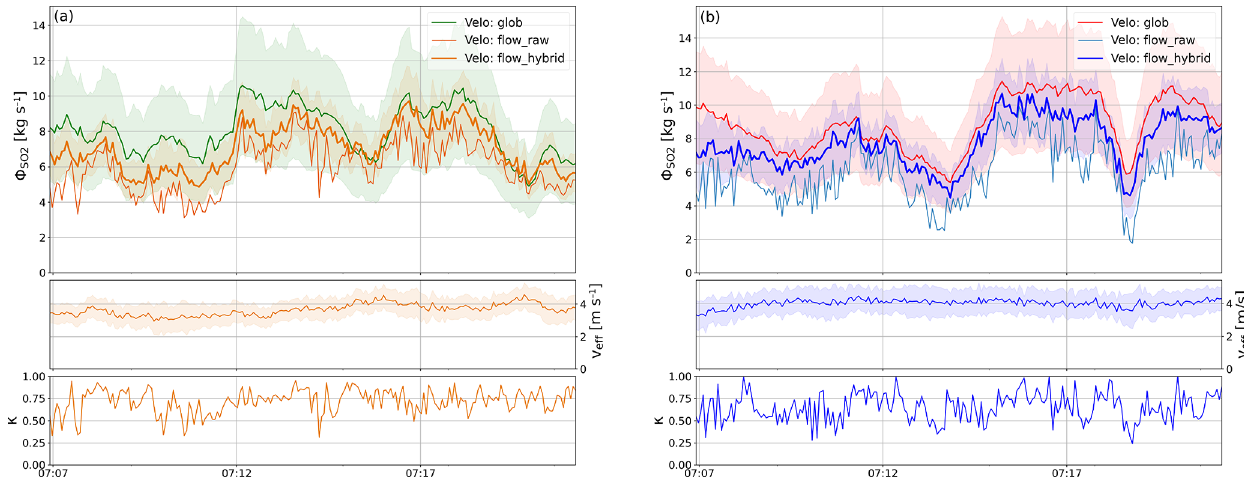
Figure 6. Time series of Etna emission rates (top panel), showing emissions of the young (a) and the aged (b) plume of the NE crater (orange and blue) using the two PCS lines shown in Fig. 1. Emission rates were retrieved using the three different velocity retrieval methods described above. Uncertainties (shaded areas) are only plotted for the flow_hybrid method and the cross-correlation method ( glob ). Also included are time series of effective velocities (Eq. 4, middle panel) and κ values (Eq. 7, bottom) retrieved from the proposed histogram analysis.